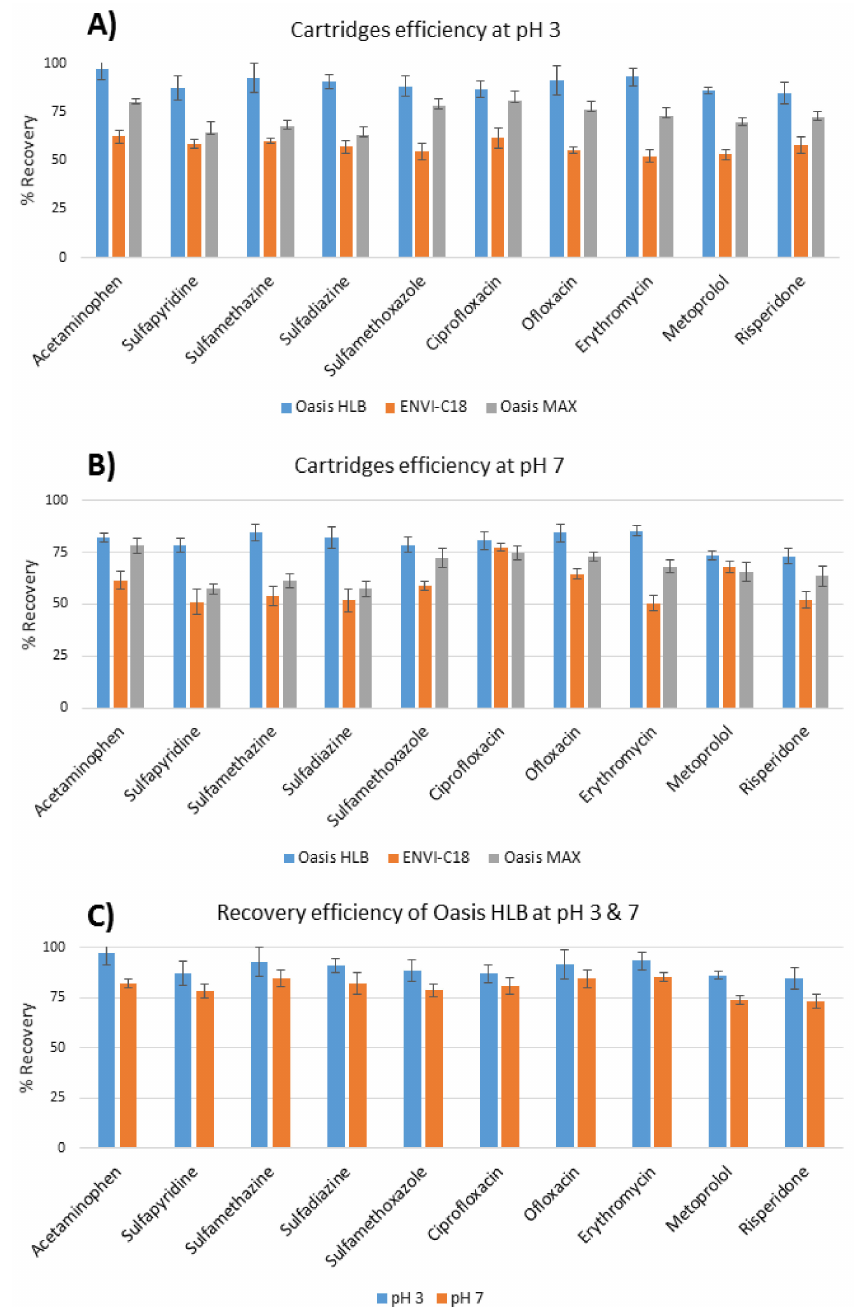
Figure 1. Graph bars showing the effect of pH on the % recoveries of the selected pharmaceuticals at ( A ) pH 3 using Oasis HLB, ENVI-C18 and Oasis MAX cartridges. ( B ) pH 7 using Oasis HLB, ENVI-C18 and Oasis MAX cartridges ( C ) comparison of the recoveries at pH 3 and 7 using HLB oasis cartridge using Oasis HLB, ENVI-C18 and Oasis MAX at two pH values (n =